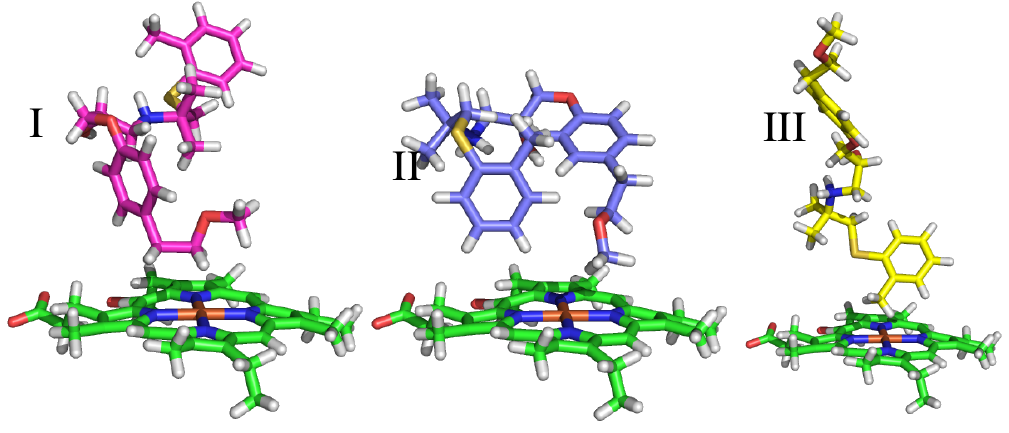
Figure 2. Diversity in ligand binding orientations with respect to the CYP 2D6 heme moiety (in green), as typically obtained from the automated docking and clustering procedure (steps 1 – 3 , Figure 1). Here, central structures are shown for the three most populated clusters of docking poses obtained for ligand 8 in protein template